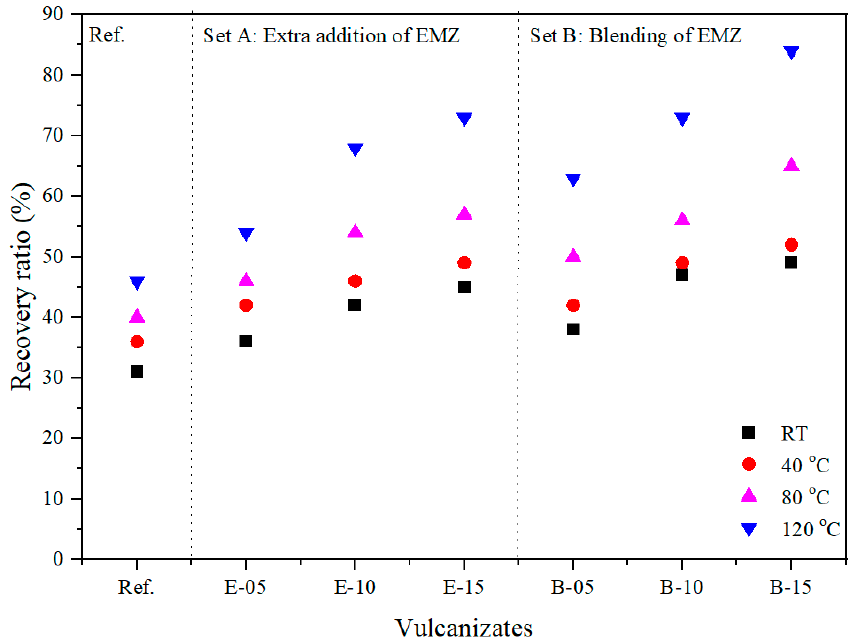
Figure 10. Recovery of the hysteresis after a tensile cyclic test (10 cycles) of silica-filled NR vulcan- izates with different contents of EMZ modifier added via either extra addition (Set A) or blending (Set B) .